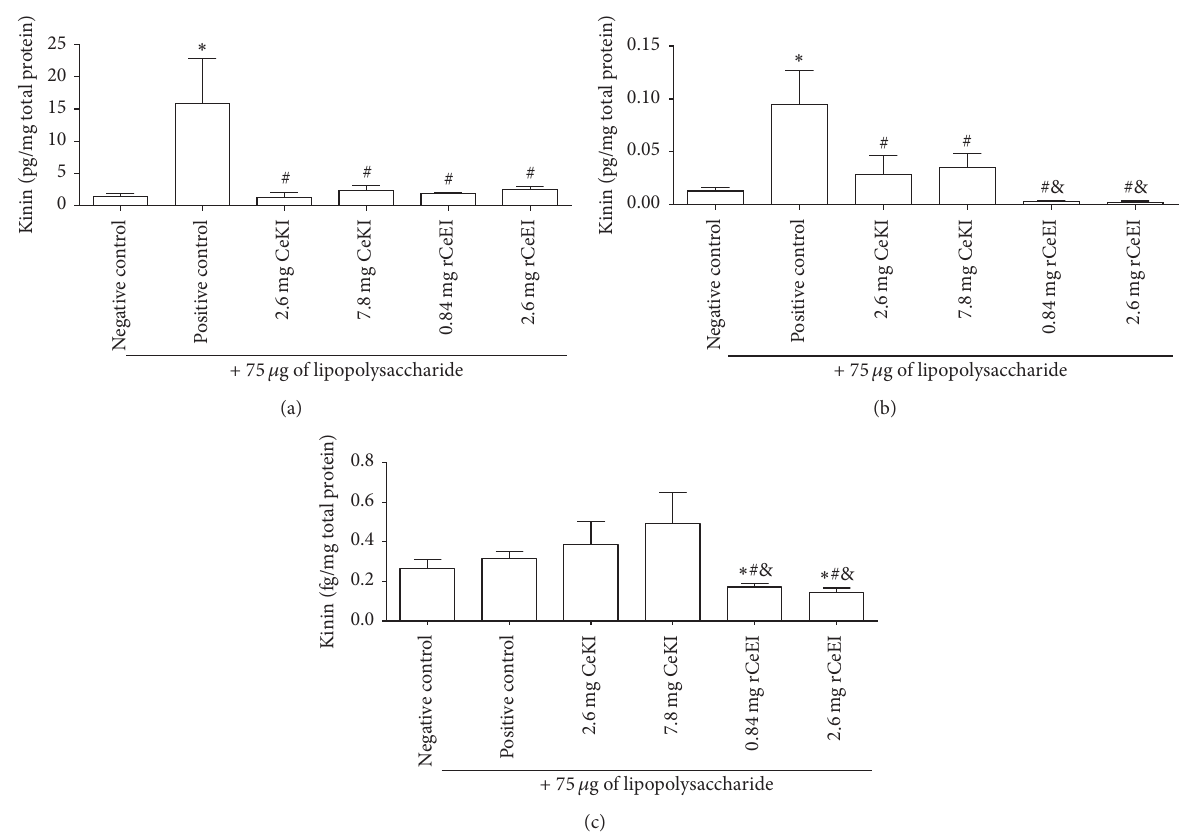
Figure 2: Kinin release in BALF, plasma, and lungs. Rats were pretreated intravenously with buffer (negative or positive controls), CeKI (7.8 or 2.6 mg), or rCeEI (2.6 or 0.84 mg). After 20min, they received 75 𝜇 g of LPS/animal (positive control and CeKI and rCeEI groups) or buffer (negative control) injected via the trachea directly into their lungs. Six hours later, blood was collected, BALF was obtained, and lungs were extracted. Kinin was extracted from BALF (a), plasma (b), or homogenized lung (c) using a treatment with ethanol and then water, acetone, and petroleum ether. For kinin quantification, a radioimmunoassay was performed according to Shimamoto et al., 1978, with some modifications [21]. The experiment was performed twice and radiation values were converted into kinin (pg) using a standard curve. ∗ Significant difference compared to negative control ( 𝜌 < 0.05). # Significant difference compared to positive control (𝜌 < 0.05) . & Significant difference compared to CeKI-treated groups (𝜌 < 0.05)